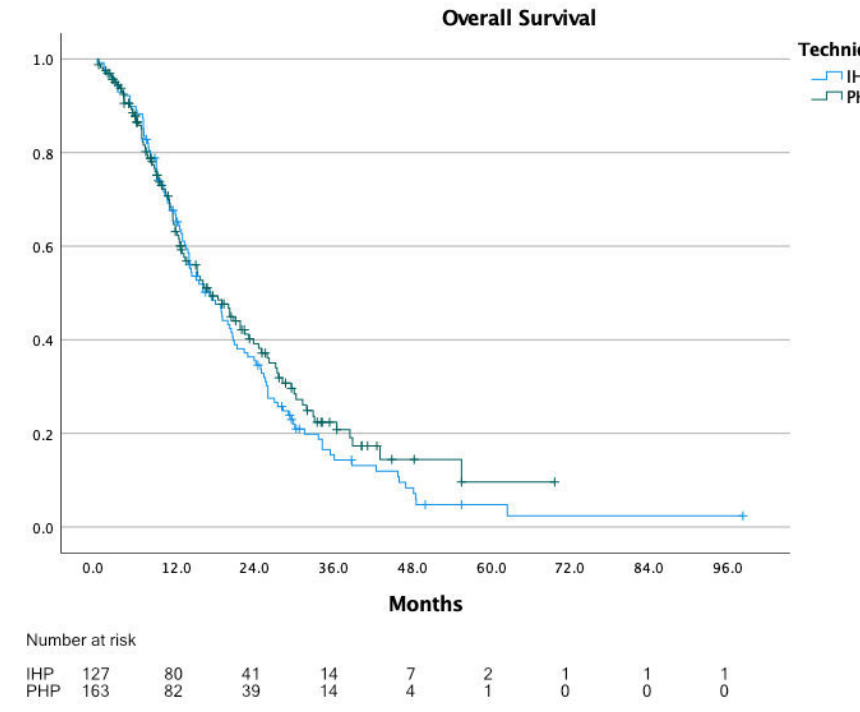
Figure 3. Overall survival comparing IHP vs. PHP.